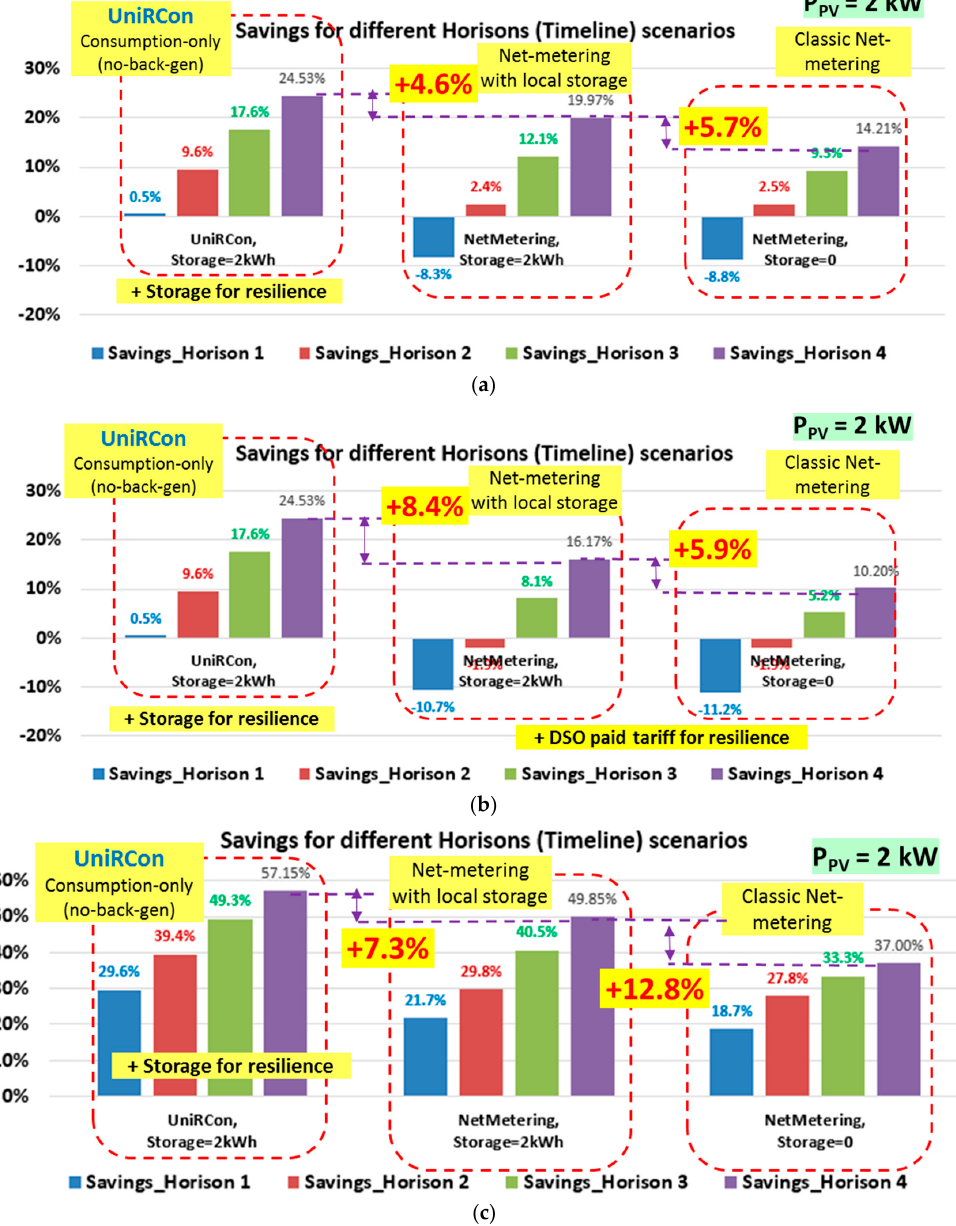
Figure 8. ( a ) Cost-savings (example) comparison for the three use-cases: net metering with or without storage and UniRCon (no-back-generation) solution—investment costs based on Table 4; ( b ) cost savings (example) comparison for the three use-cases: net metering with or without storage and UniRCon (no-back-generation) solution—investment costs based on Table 4 and DSO tariff for resilience; ( c ) cost savings (example) comparison for the three use-cases: net metering with or without storage and UniRCon (no-back-generation) solution for a house in San Diego, California.